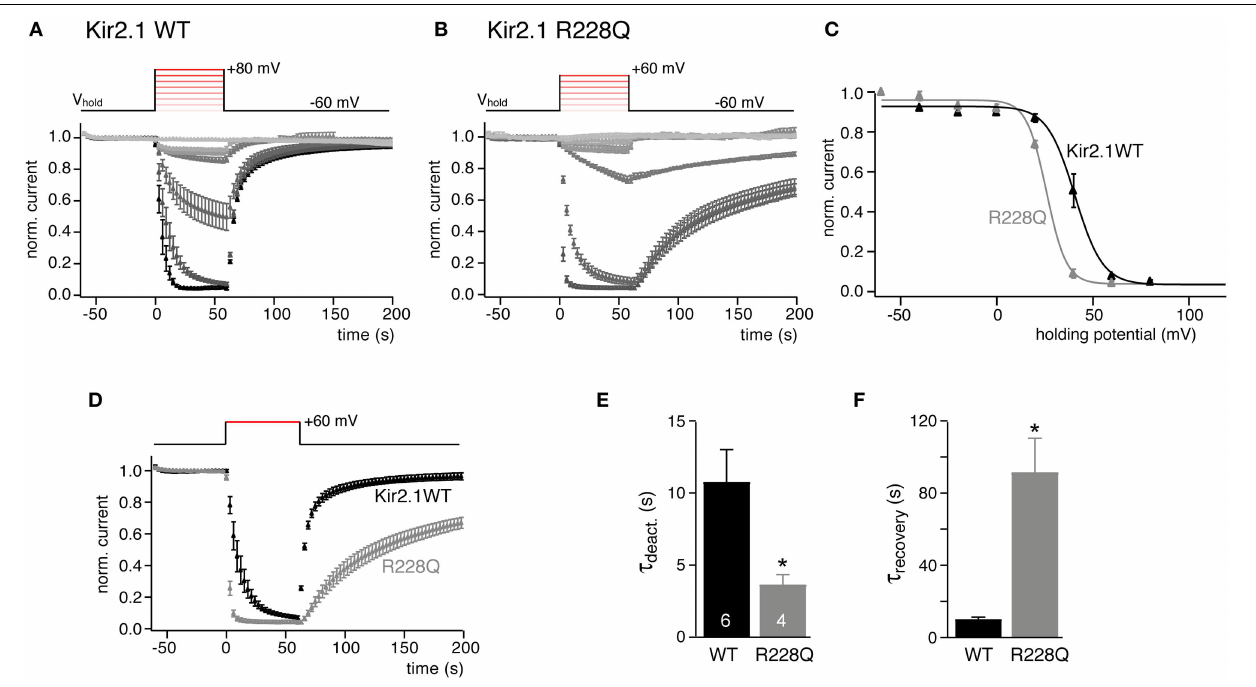
voltage-dependent inhibition of Kir2.1 and Kir2.1 R228Q currents. Continuous lines indicate fits of a Boltzmann function to the data. (D) Comparison of time course of Kir2.1 and Kir2.1 R228Q current deactivation and recovery in response to potential-dependent activation Ci-VSP (data replotted from A,B ). (E,F) Mean time constants ( ± SEM) of current deactivation and recovery from the individual recordings shown in (D) . Time constants were derived from mono-exponential fits to individual recordings. Numbers of experiments (individual oocytes) as indicated. Asterisks indicate p ≤ 0 . 05